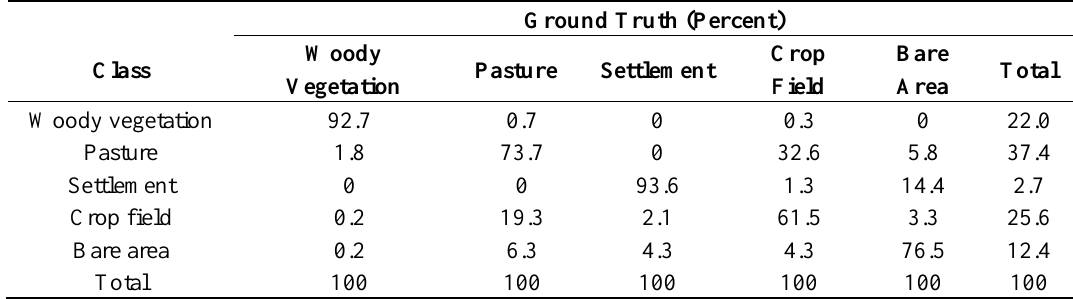
Table A1. Confusion matrix—1979 image classification before pansharpening. Overall Accuracy = 75.88%, Kappa Coefficient =